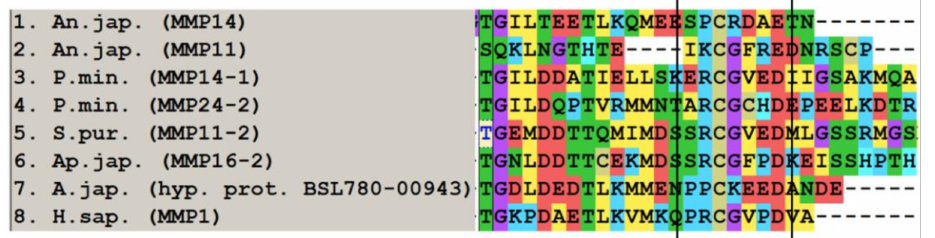
Figure 2. MUSCLE (MegaX) alignment of cysteine switch sequences (boxed area) of some MMPs of echinoderms.